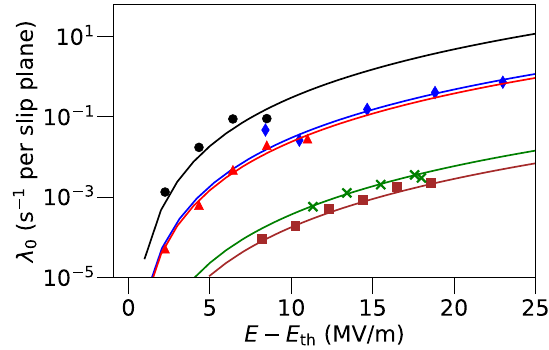
FIG. 7. Rate of current spikes as a function of the electric field, experimental (markers, whose size also accounts for experimental error) and theoretical (lines), for the measurement series listed in Table I. The theoretical lines differ only in the parameter β , as detailed in the